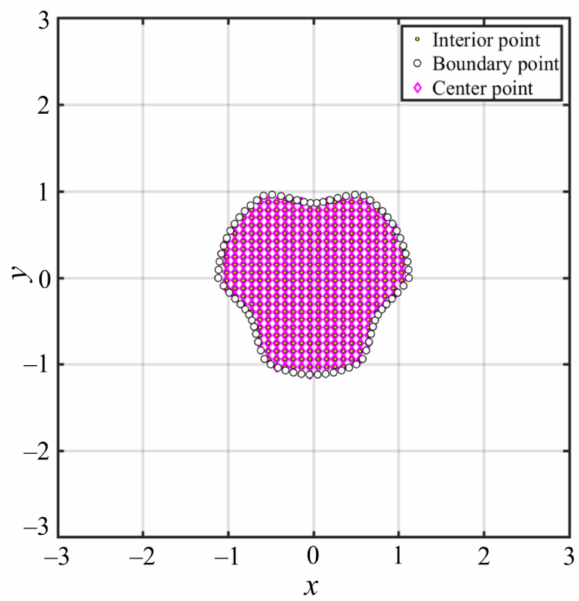
Figure 9. The conventional RBFCM collocation scheme.